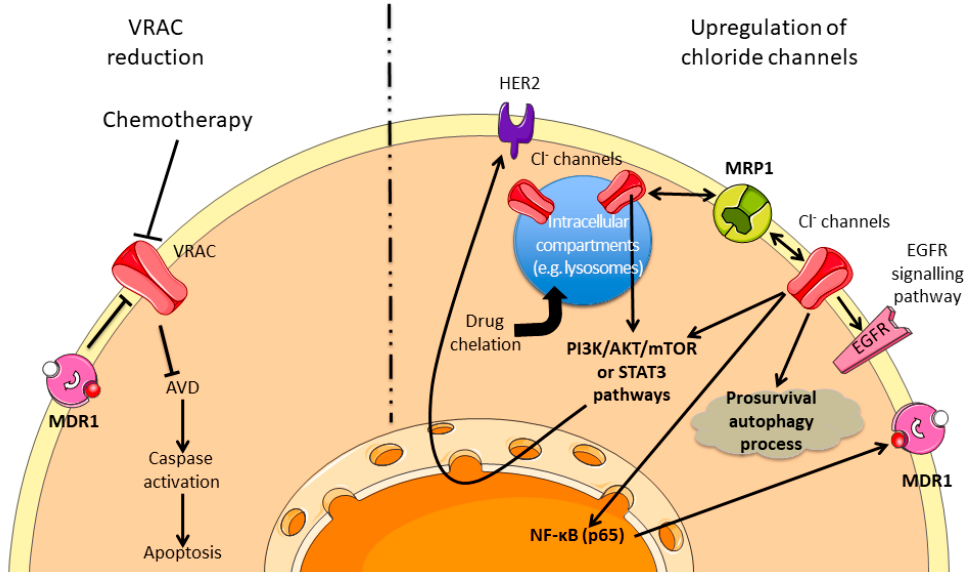
Figure 5. Chemoresistance pathways involving Cl − channels. Cl − channels can modulate the sensitivity to different chemotherapies by inhibiting the AVD or by modulating the prosurvival pathways and the drugs availabilities. The dashed line separates two virtual cells presenting either reduction activity of Cl − channels (left part) or an upregulation of Cl − channels (right part). MDR1: Multidrug Resistance 1; VRAC: Volume Regulated Chloride Channel; AVD: Apoptosis Volume Decrease; HER2: Human Epidermal growth factor Receptor 2; MRP1: Multidrug associated Resistance Protein 1; EGFR: Epidermal Growth Factor Receptor.